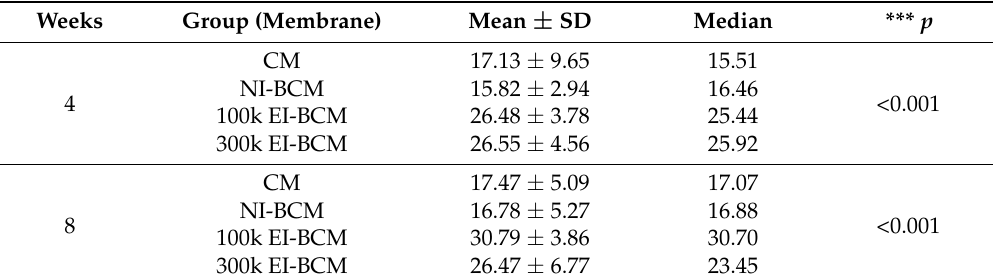
Table 1. New bone area percentages within areas of interest ( n = 6%).